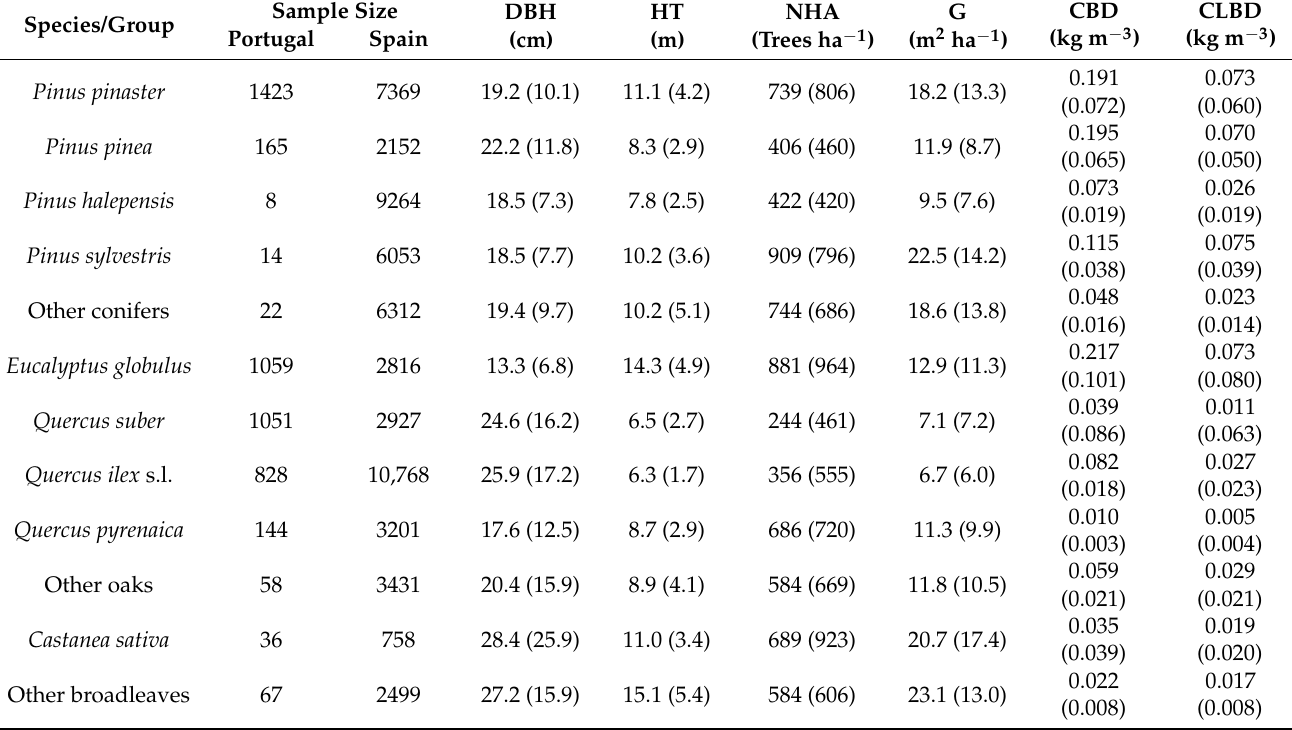
Table 5. Tree species or group of species used for the estimation of the tree Crown Bulk Density (CBD, in kg m − 3 ) and Canopy Layer Bulk Density (CLBD, in kg m − 3 ), with the indication of the sample size and stand variables in the Iberian Peninsula (mean values and standard deviation in parenthesis). DBH = tree diameter; G = stand basal